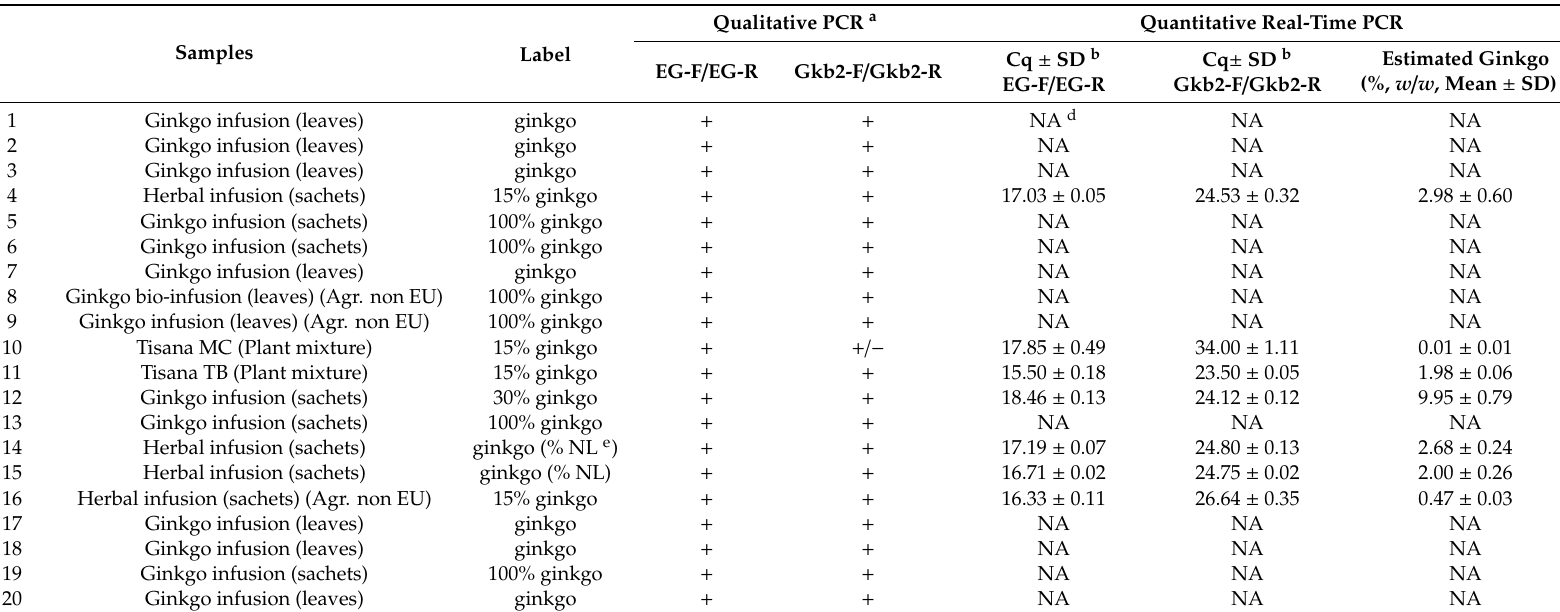
a ( + ) Positive amplification; ( − ) Negative amplification; +/ − Doubtful amplification. b Mean cycle of quantification (Cq) values ± standard deviation (SD) ( n = 4). c Mean percentage (%) values ± SD ( n = 4). d NA—not applicable. e NL—not